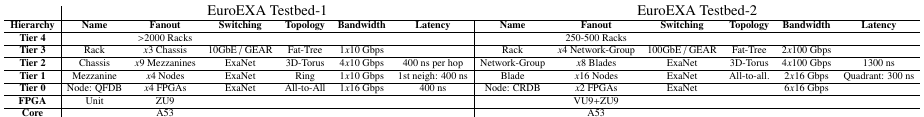
Table 1. The EuroEXA multi-tiered network. A comparison of TB1 and TB2